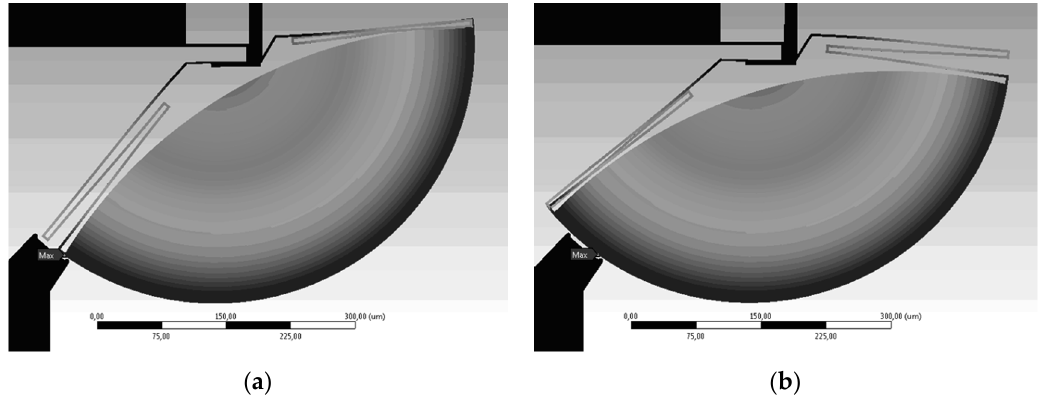
Figure 10. Simulated resonance of the structure: ( a ) First extremum, and ( b ) second extremum.